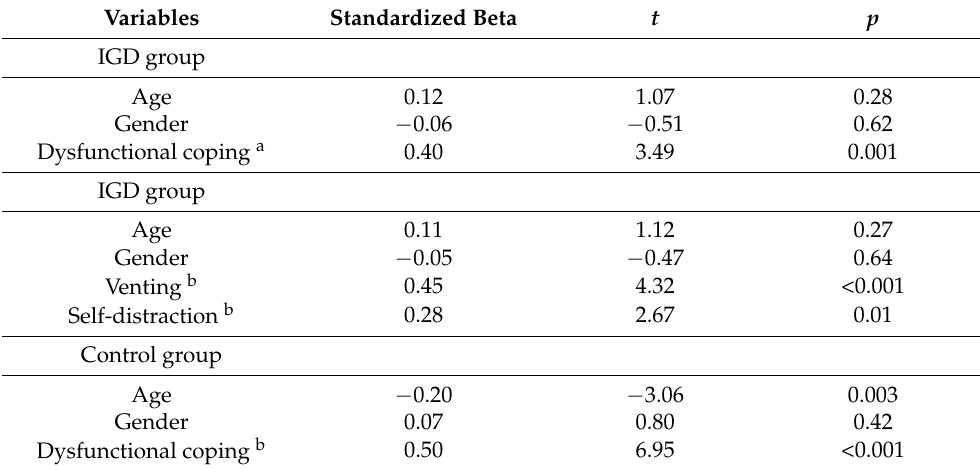
Table 4. Results of linear regression analysis to regress coping by gaming a on coping strategies among the internet gaming disorder (IGD) group or the control